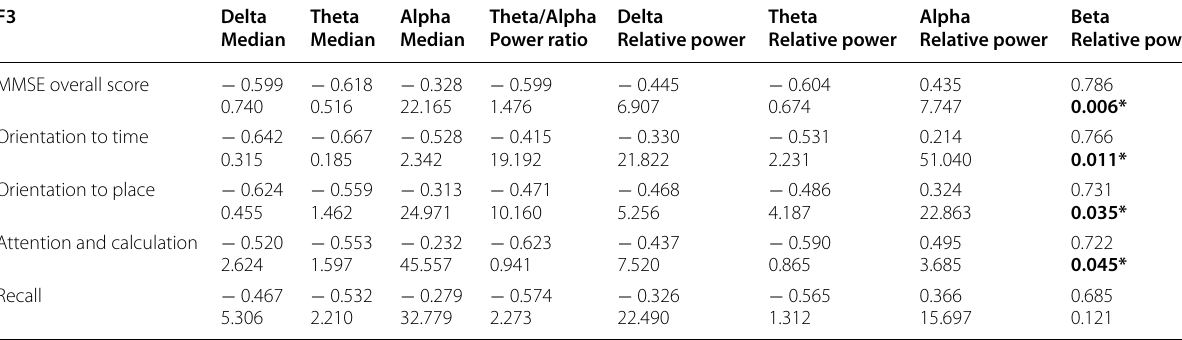
Bold number means positive correlation. First line of each cell represents the Pearson correlation coefficient, and second line represents corrected p -value by multiplying by 280